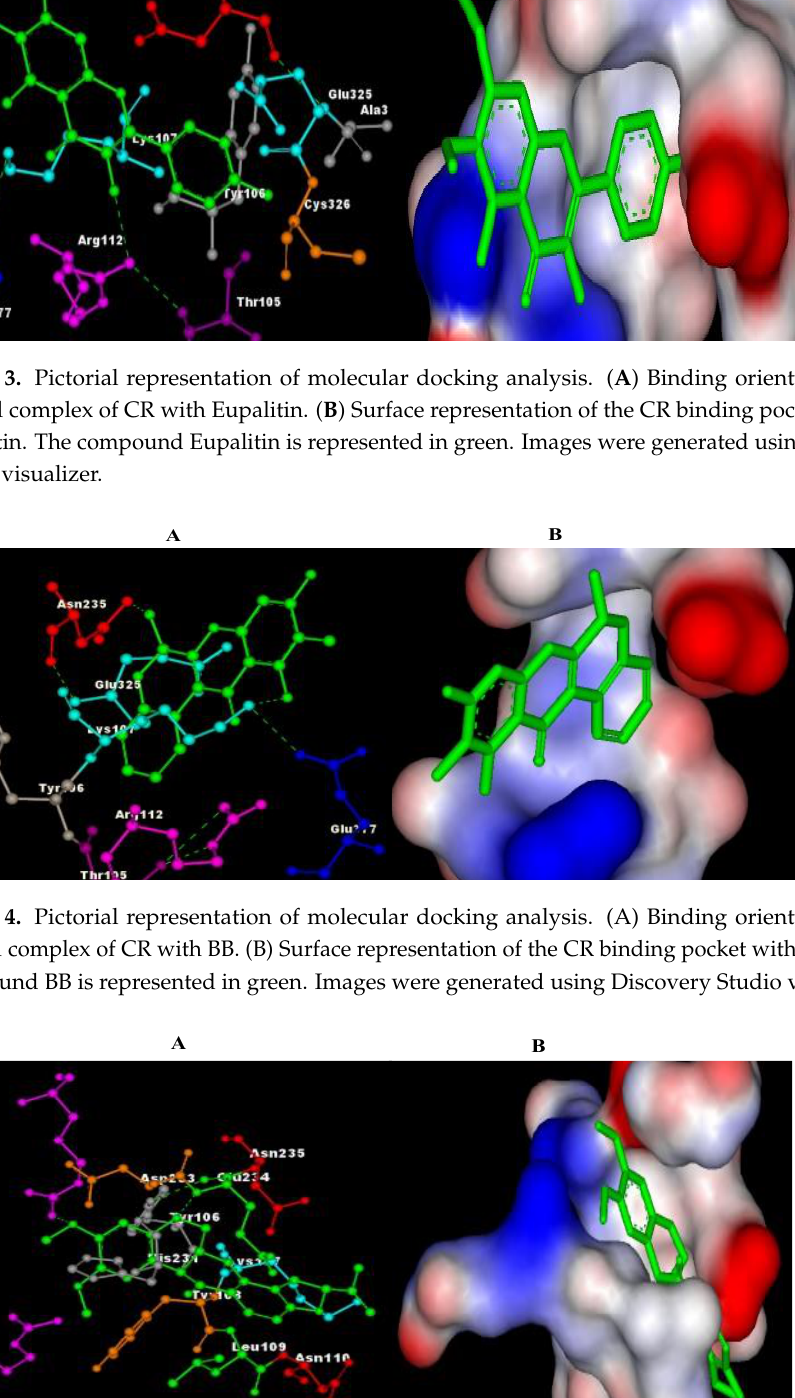
Figure 6. Pictorial representation of molecular docking analysis. ( A ) Binding orientation in the docked complex of CR with sibutramine. ( B ) is represented in green. Images were generated using Discovery Studio visualizer. Surface representation of the CR binding pocket with the sibutramine.